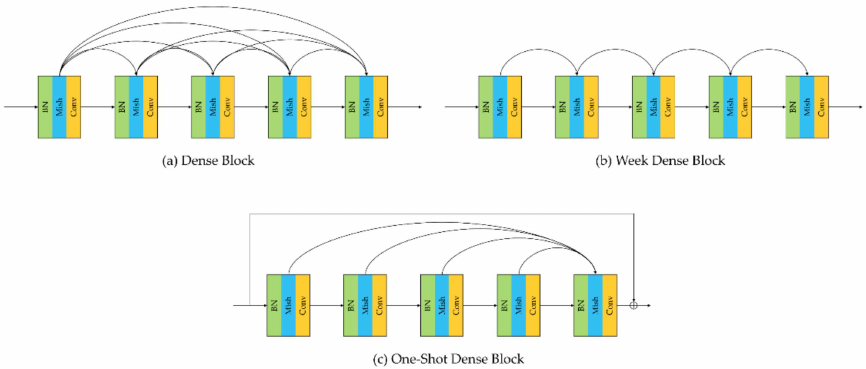
Figure 15. Different dense blocks. ( a ) Dense block. ( b ) Week dense block. ( c ) One-shot dense block. Table 17. The number of parameters, FLOPs, and OA of different dense blocks on the PU dataset. Dataset